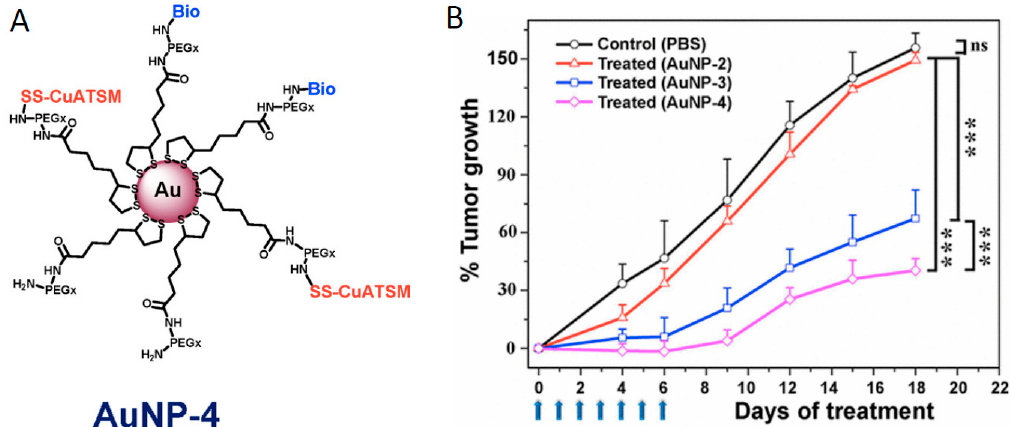
Figure 5. ( A ) Schematic illustration for the synthesis of PEG stabilized gold nanoparticles and nanoconjugates. ( B ) In vivo anticancer activity of AuNPs in mice bearing HeLa xenografts. *** indicates p < 0.001. Reprinted with permission from reference [92].